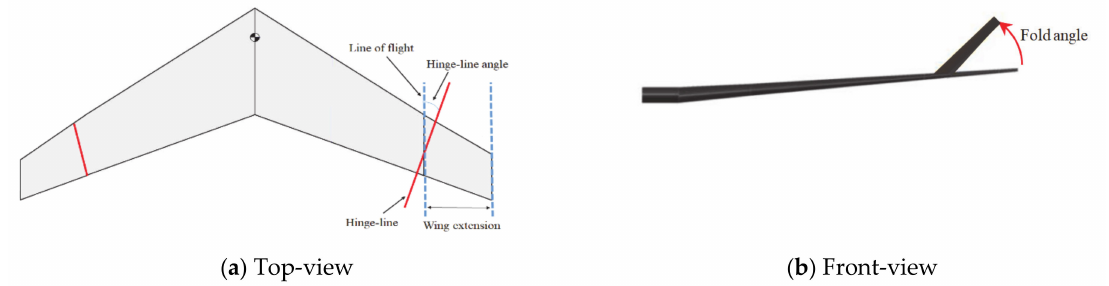
Figure 1. Swept wing equipped with flared hinge folding wingtip “From [1]; reprinted by permission of the American Institute of Aeronautics and Astronautics,